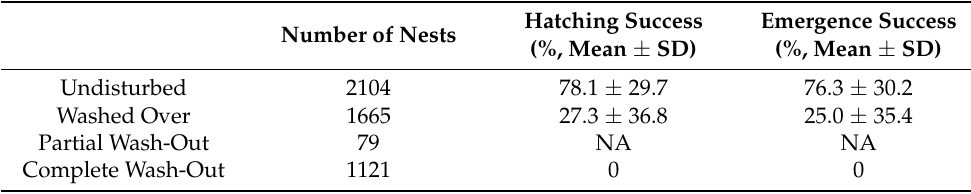
Table 2. Hatching and emergence success for undisturbed and wave-exposed loggerhead turtle nests in the Florida Panhandle from 2016 to 2019. Number of nests and complete and partial wash-outs are derived from the full available dataset (n = 6773). Hatching and emergence success from undisturbed and washed over nests were evaluated from a subset of the available data (n = 2947) to remove potential covariance effects. NA: productivity from partially washed-out nests is impossible to determine without a known clutch size prior to